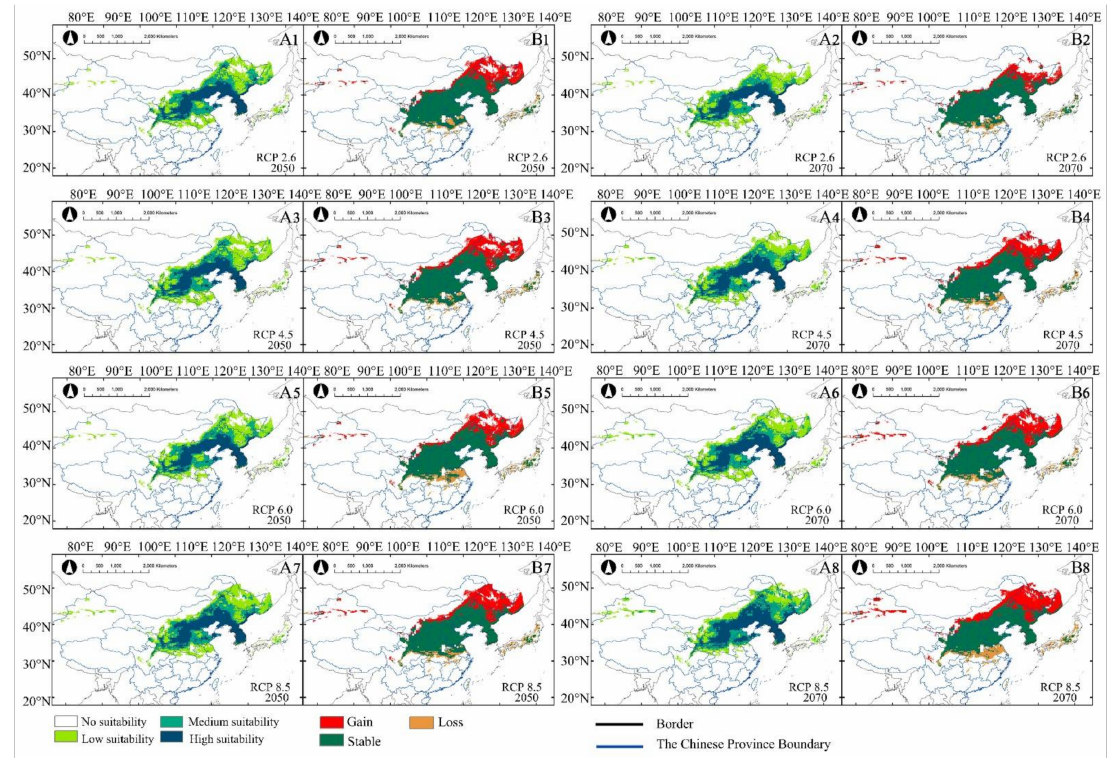
Figure 4. Under future climate change scenarios (2050s and 2070s), ( A1 − A8 ) are potentially suitable distributions of A. truncatum . ( B1 − B8 ) are the area changes of A. truncatum compared to the distribution under current climate scenario.